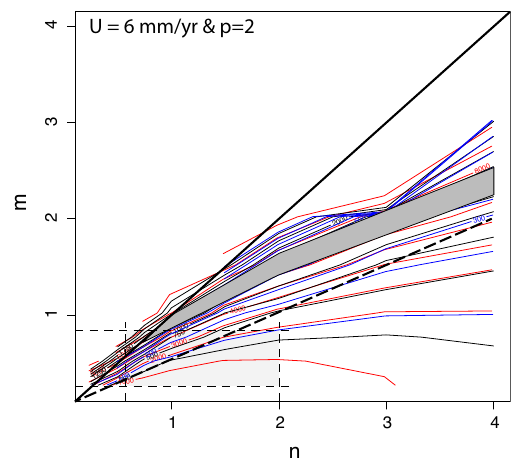
n Figure 8. Contour plots of predicted time lags at the three Mi- lankovitch periods (blue at 23ka, black at 42ka and red at 100ka) as a function of m and n . The dark grey shaded area corresponds to the values of m and n that satisfy the three time lags derived from the spectral analysis of geochemical data from the Bengal Fan (Gourlan et al., 2014); the light grey shaded area corresponds to the range of commonly accepted values for m and n